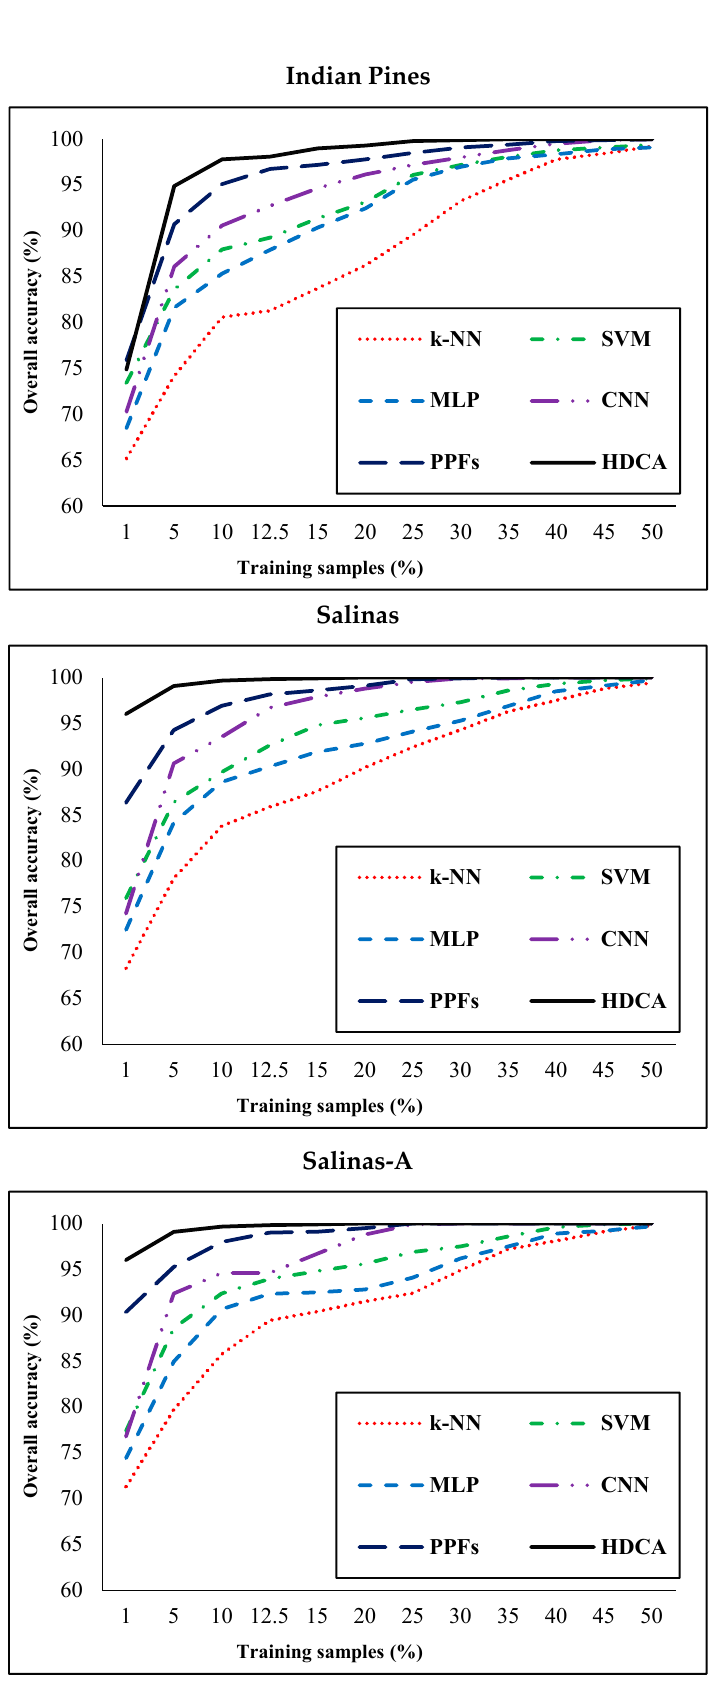
Figure 12. The effects of training samples on accuracies of three data sets.